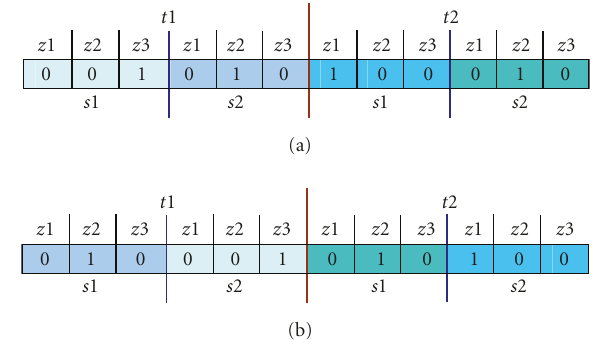
Figure 3: Sensor-exchange crossover operation (a) before crossover and (b) after crossover. s 1 and s 2 are exchanged at both times t 1 and t 2 to generate a new chromosome.